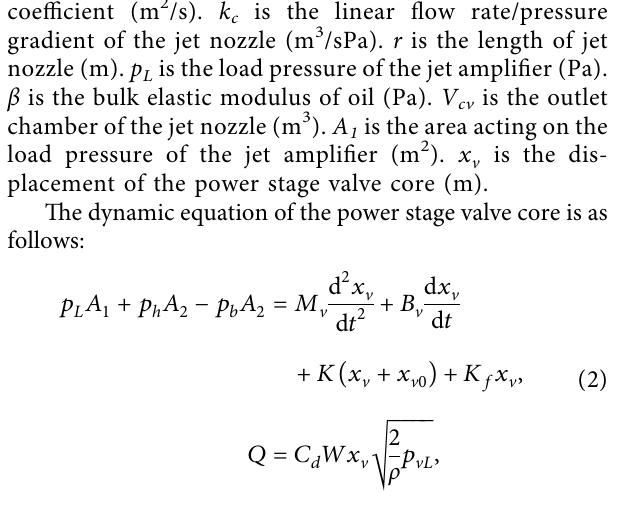
Figure 9: Simulation results of the front stage under fxed return oil pressure. (a) Brake pressure p Oil return pressure p h . (d) Oil return pressure p h FFT